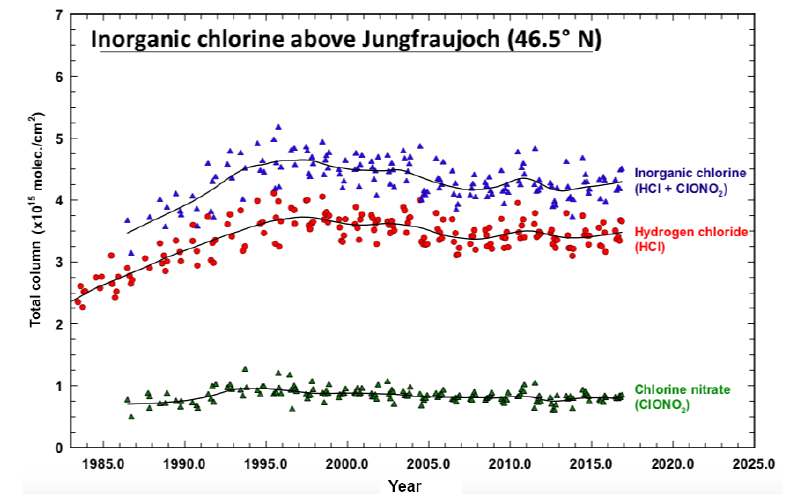
Figure 9. Multidecadal time series of column amounts above Jungfraujoch of ClONO 2 and HCl, as well as the sum of both, which is a proxy of total inorganic chlorine. Symbols represent monthly means. To avoid masking of trends by polar winter dynamics, only the months June to November were considered. The continuous lines are non-parametric least squares fits. A decrease since 1996/97 and correlations between the column amounts of ClONO 2 and those of HCl are visible. Figure by Emmanuel Mahieu et al., Univ. Liège, published in De Maziére et al. (2018), used under CC Attribution 3.0